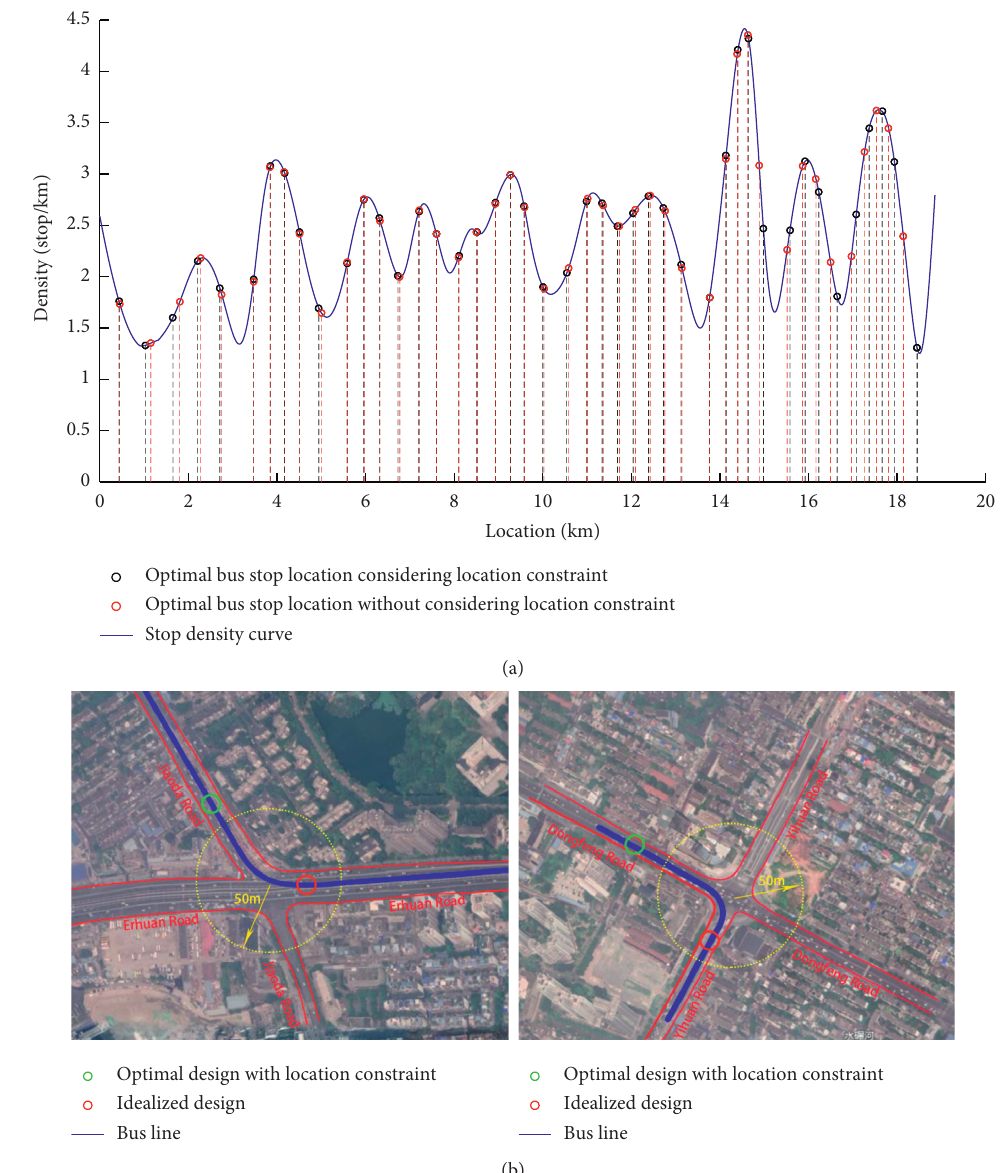
Figure 5: Stop locations for the optimized transit service. (a) Stop locations with and without the location constraint. (b) Locations of 10th and 23th stops for different results.